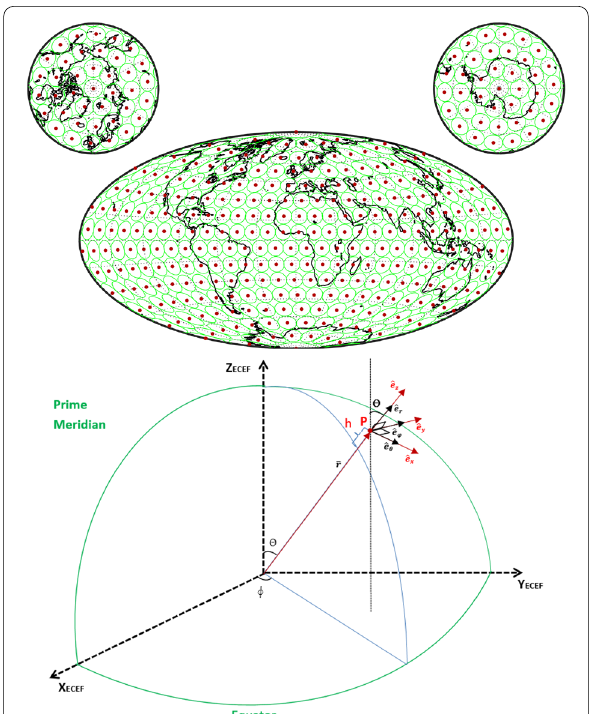
Fig. 3 Top: distribution of the 300 GVOs (red dots) and associated cylinder bins (in green) using a Hammer projection. Bottom: illustration of the geocentric coordinate system and the local topocentric Cartesian coordinate system used in the GVO estimation (in